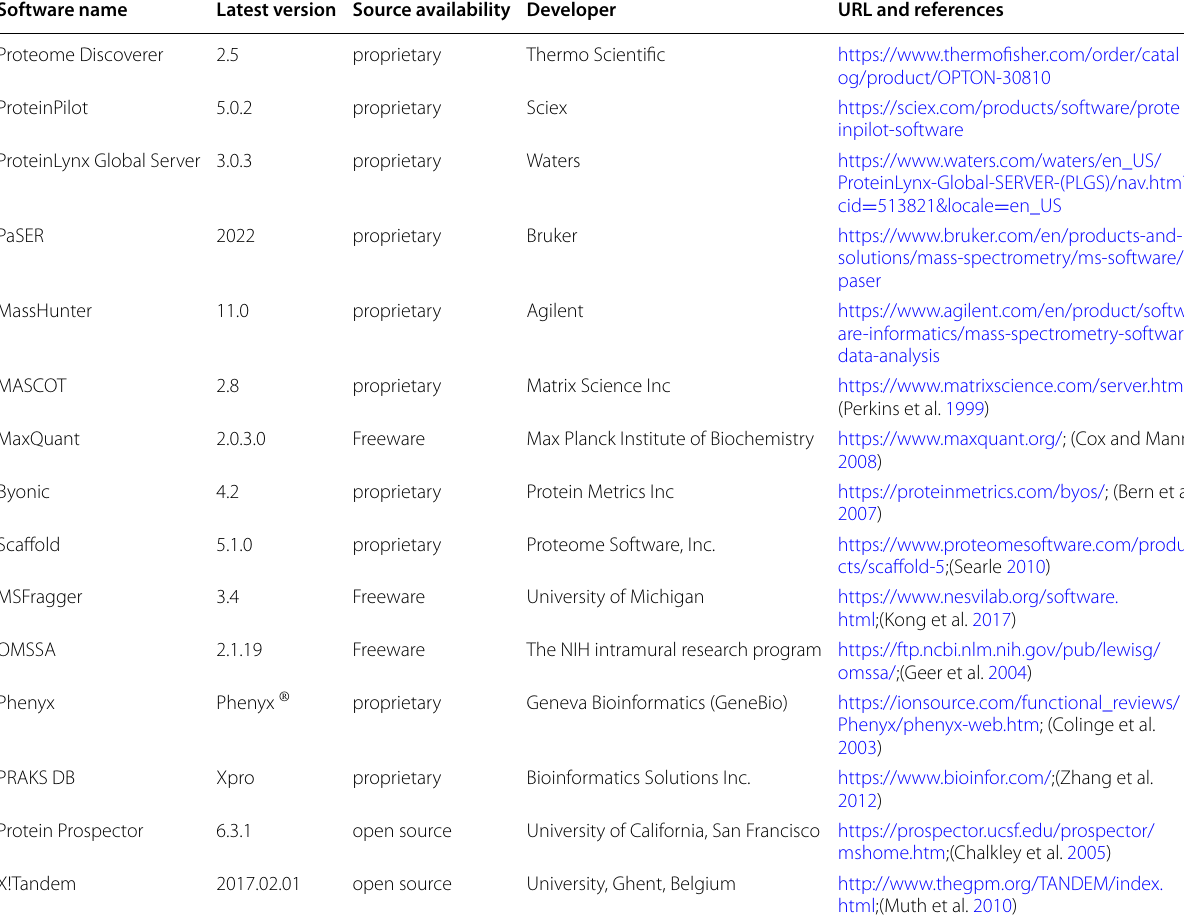
Table 1 A partial list of commonly used database search software tools for proteomics